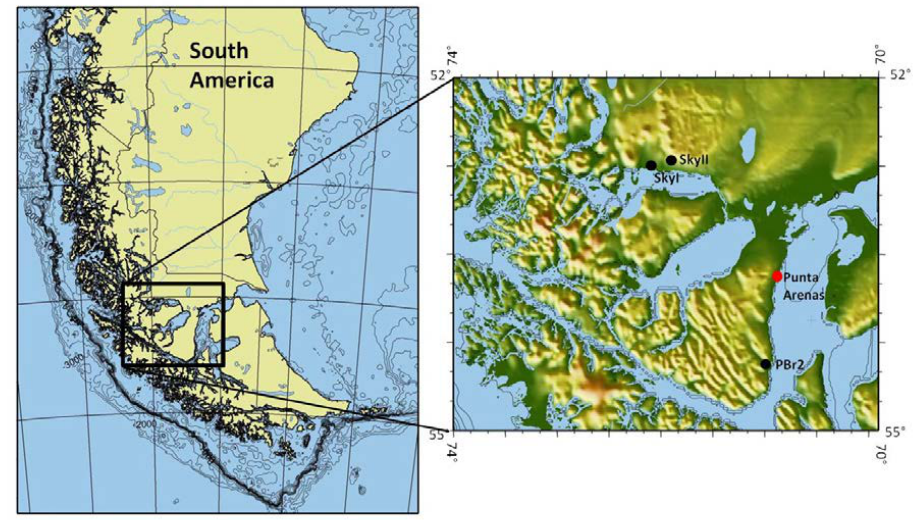
Fig. 1. Map of the study area in southern South America. Locations of the sampling sites are marked in the detailed map. Maps were generated online at https://sfb574.ifm-geomar.de/gmt-maps at 26 February 2011 (IFM-GEOMAR).